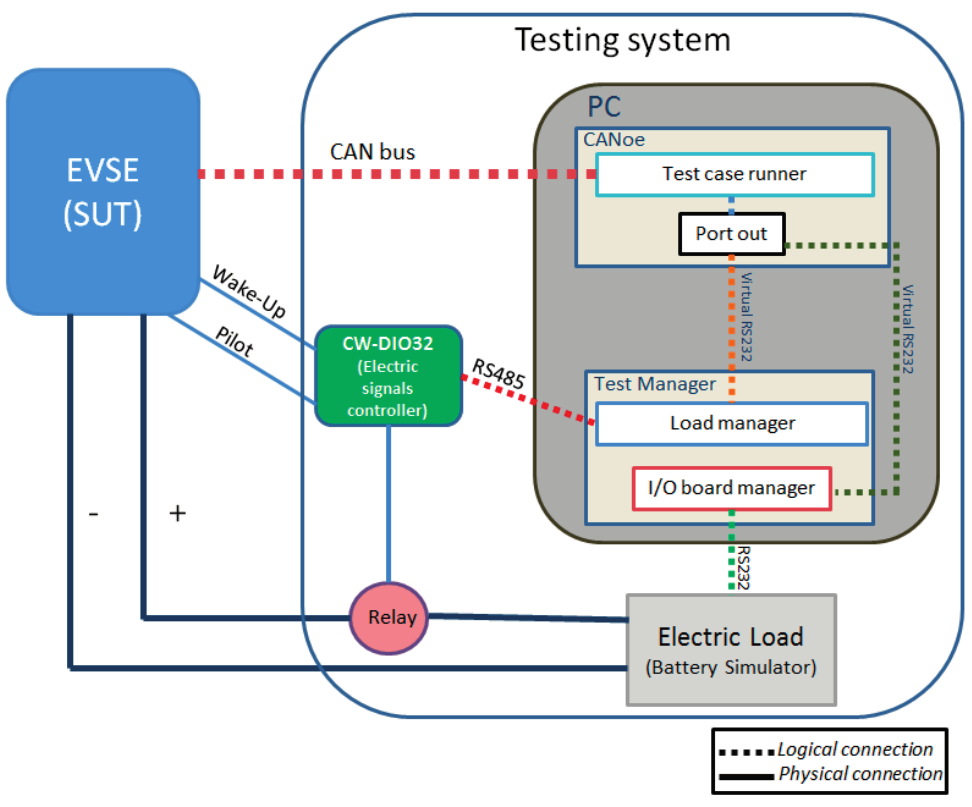
Figure 3. Physical and logical connection between components in the testing